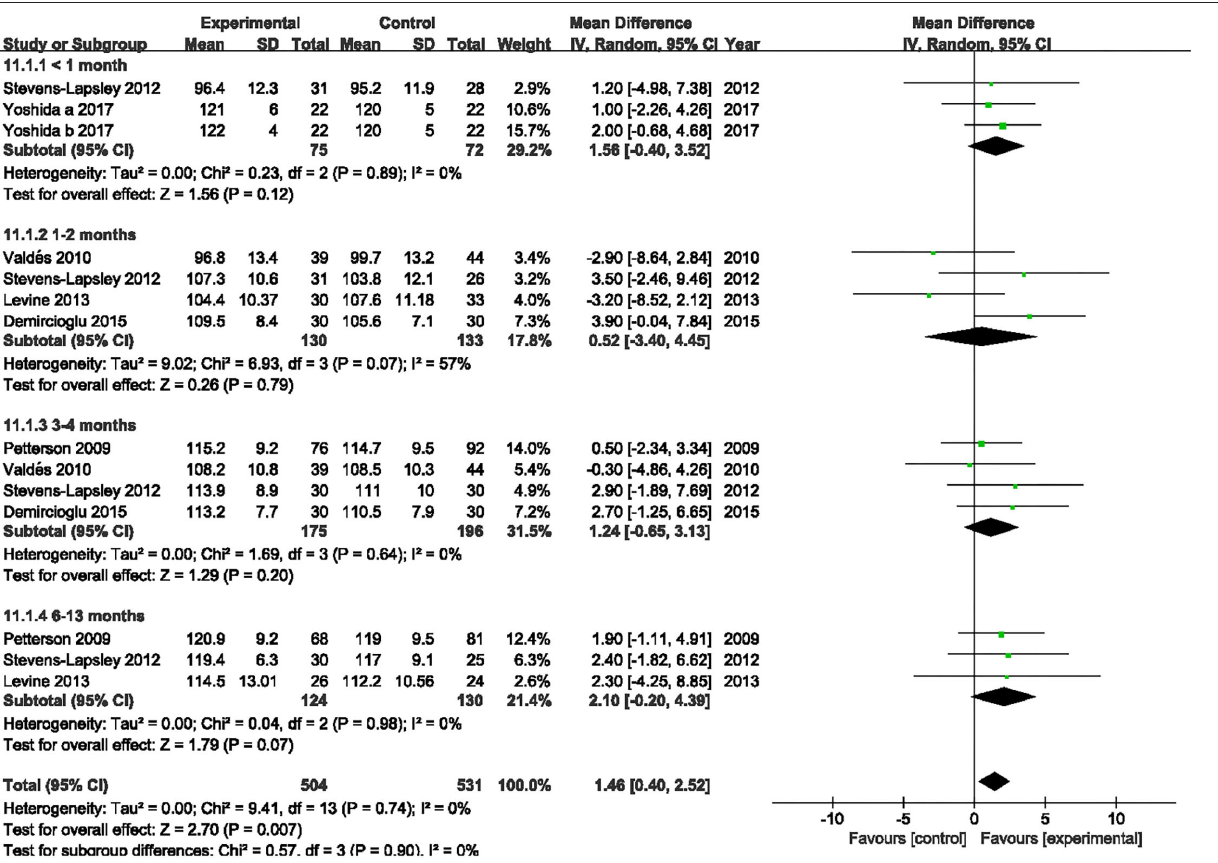
FIGURE 12 | Forest plots of meta-analysis of the effect of NMES vs. conventional rehabilitation on knee